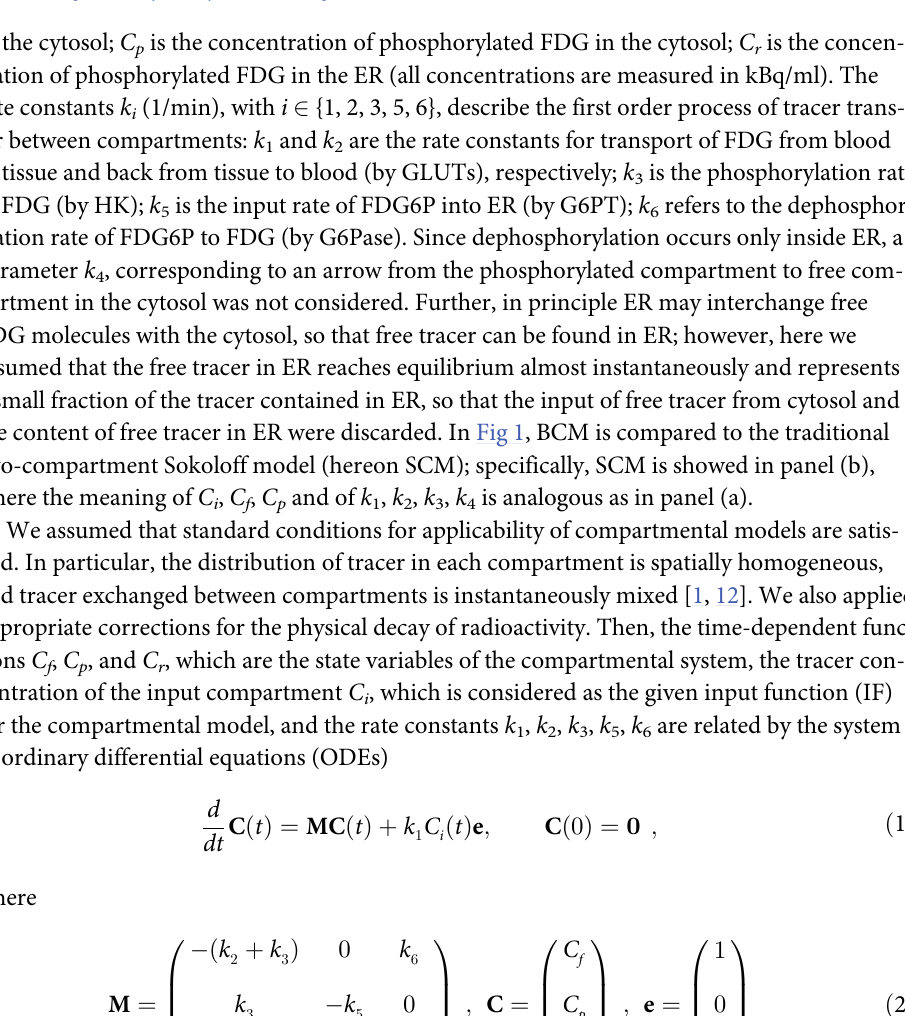
Fig 1. Compartmental models used for data analysis. (a) Biochemically-driven three-compartment model (BCM). (b) Two-compartment Sokoloff’s model (SCM). C i is the concentration of the tracer in input, C f is the concentration of the free, not phosphorylated FDG, C p is the concentration of the phosphorylated FDG in the cytosol, C r is the concentration of the phosphorylated FDG in the endoplasmic reticulum.